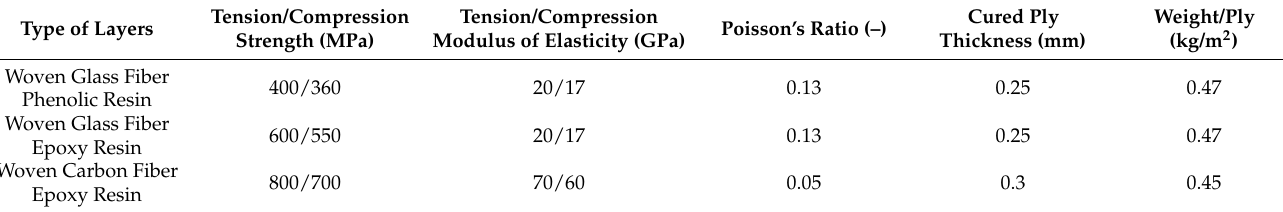
Figure 3. Composite laminated lay-ups. ( a ) Cross-ply, ( b ) angle-ply, and ( c ) multidirectional (0°, 90°, and ±45°). Table 3. Engineering properties of facing material construction [49].